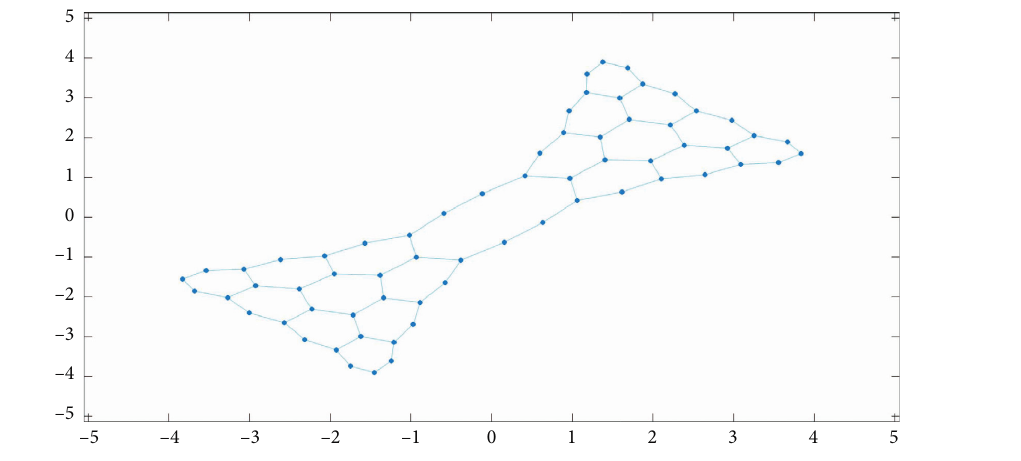
Figure 5: Hourglass carbon nanocone HGSCNC ( 3 , 10 )